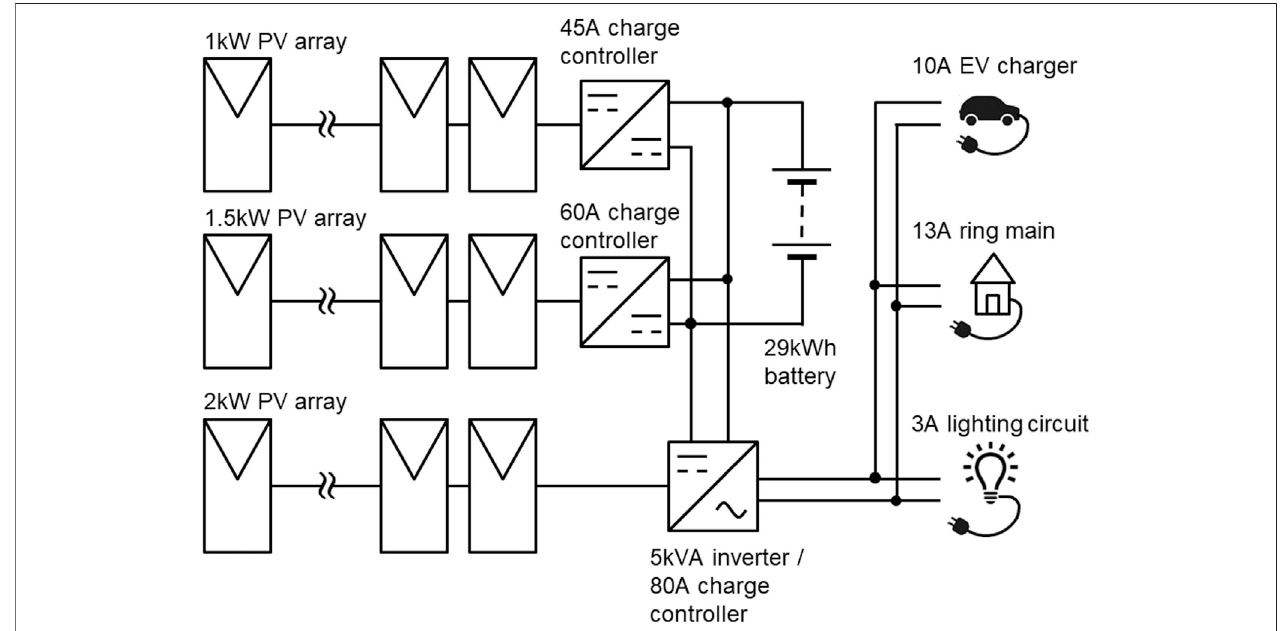
FIGURE 6 | Schematic of the solar powered minigrid at the Global Hands Community Development Hub where the Solar Taxi is recharged.